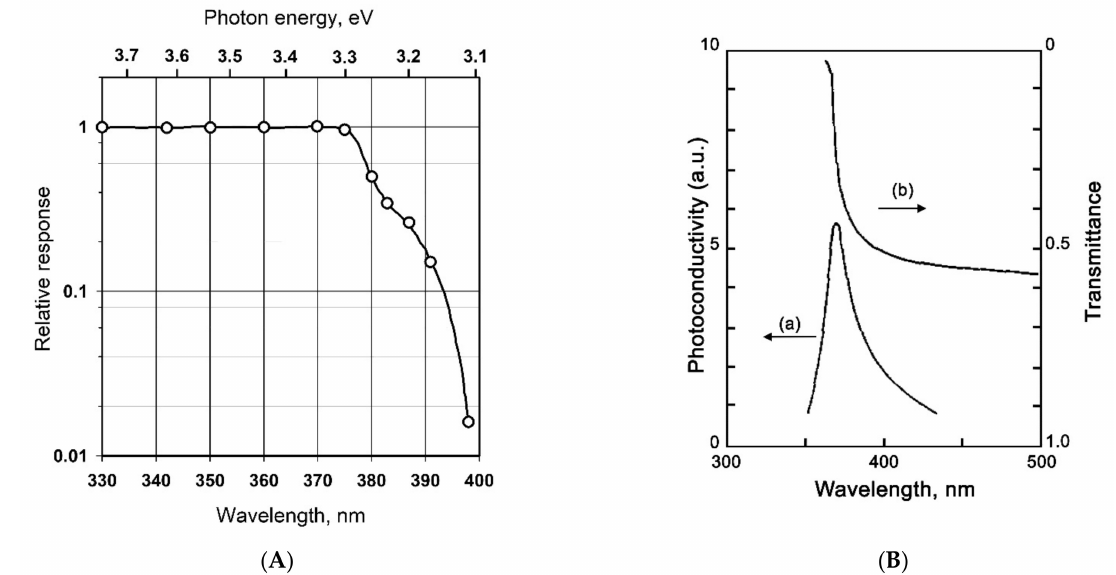
Figure 1. ( A ) Photoconductivity spectrum of monocrystallline ZnO. Adapted from [16], with permission from American Physical Society, 1958. ( B ) Photoconductivity spectrum of monocrystallline SnO 2 (a) in comparison with its optical absorption spectrum (b) Adapted from [17] with permission from AIP Publishing, 1969.